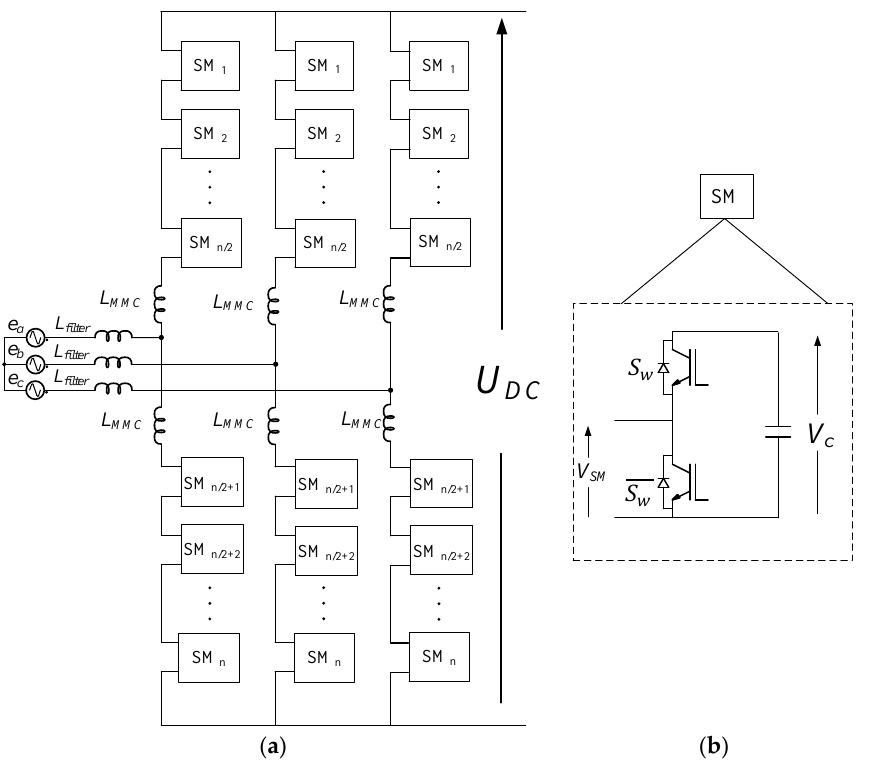
Figure 1. ( a ) Diagram of the modular multilevel converter (MMC); ( b ) Diagram of the half H-bridge submodules (SM).